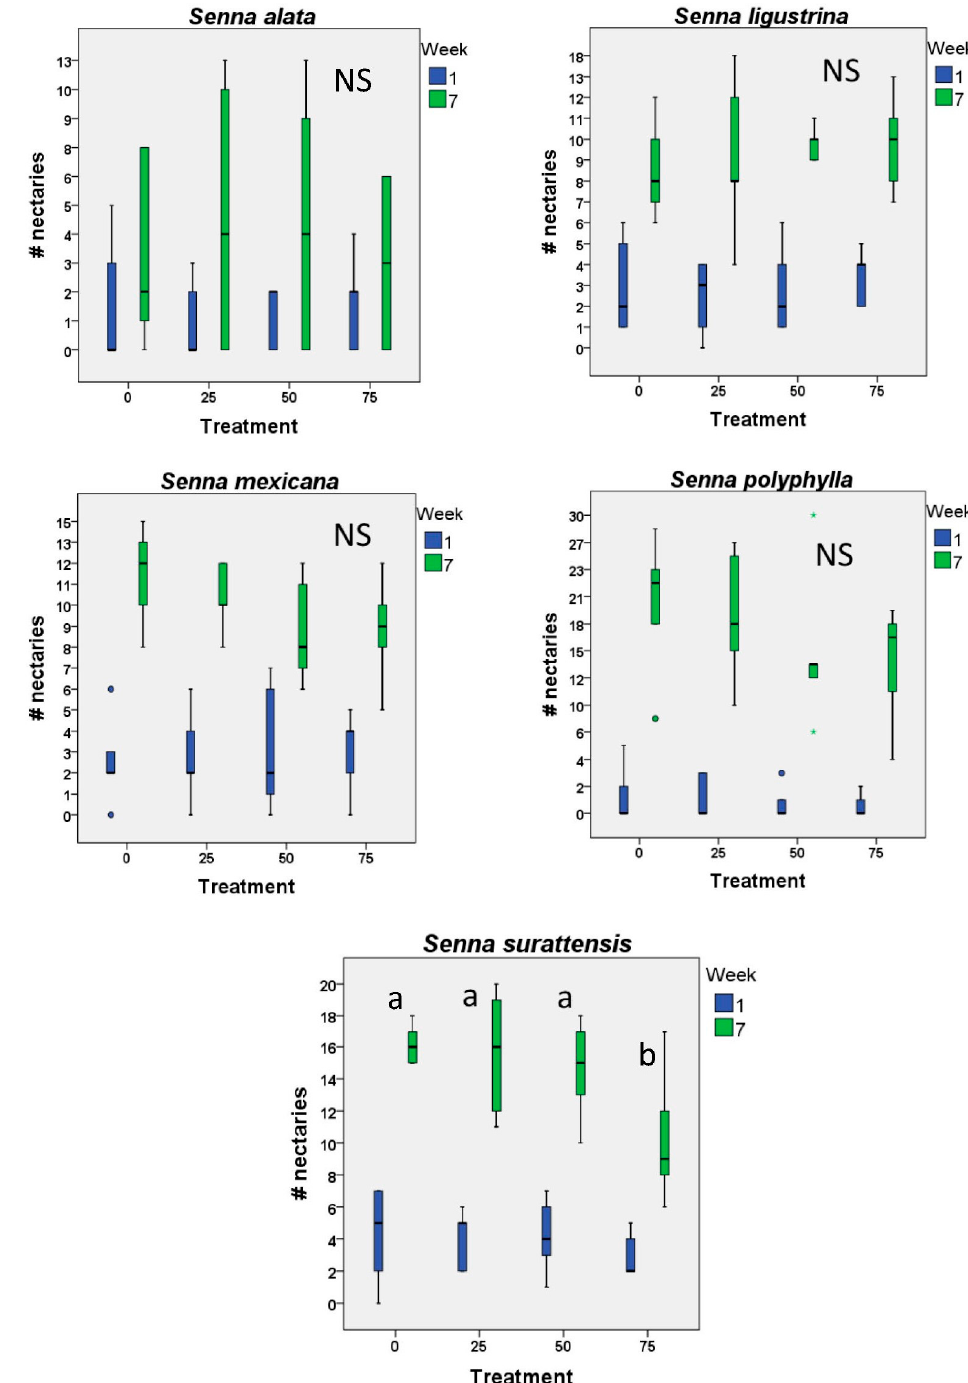
Figure 3. Extrafloral nectaries—bar and whisker plots for initial and final number of extrafloral nectaries on five species of Senna subject to different levels of artificial defoliation over the first two months of life (n = 12 plants each level and control). In no case were the initial number of nectaries different among the treatment groups. Small letters by bars indicate significant differences ( p < 0.05); bars with the same letters do not differ significantly from each other. NS indicates no significant differences found.